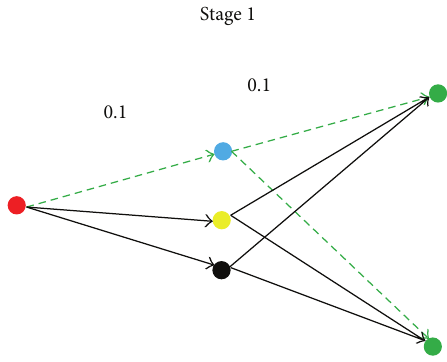
Figure 9: Calculation of arrival